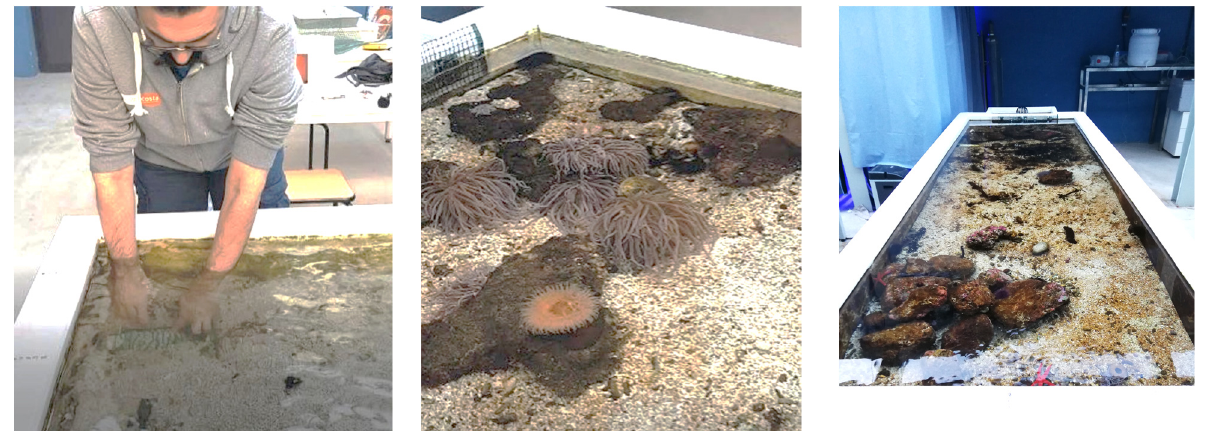
Figure 1. Seawater tank used for the biodegradation test (lasted 34 months).